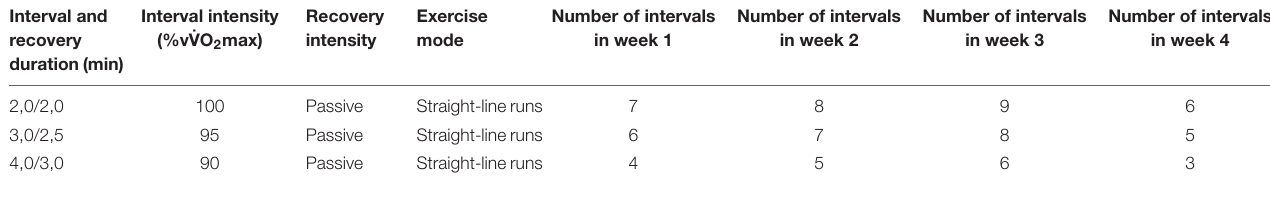
TABLE 2 | High-intensity interval training protocol